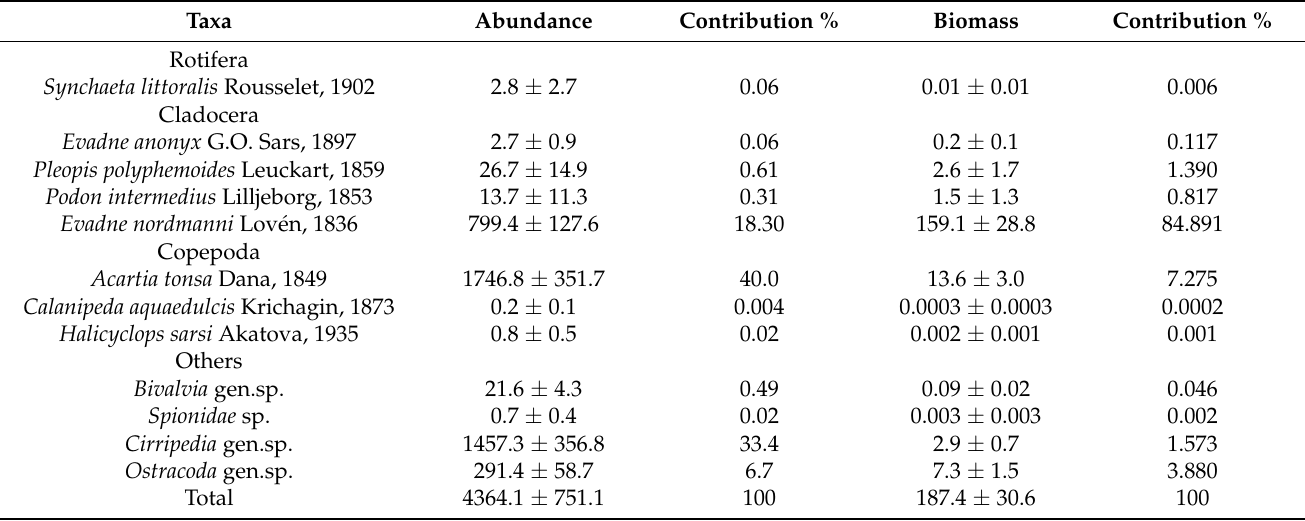
Table 2. Quantitative variables of zooplankton communities in the Middle Caspian Sea, May 2021 (average values with standard